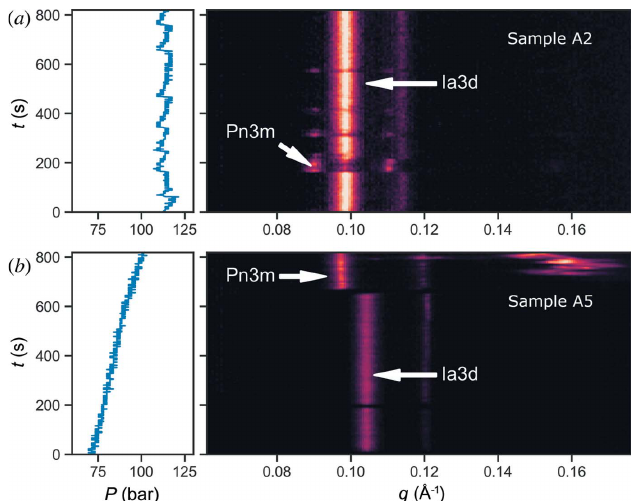
Figure 2 Illustrative data showing phase changes between the Ia 3 d and Pn 3 m cubic phases for samples injected in air at the Australian Synchrotron: ( a ) sample A3–MO, water 60:40 ( w / w ); ( b ) sample A5–MO/bR buffer and crystallization buffer 50:50. Reservoir pressure is shown in the left-hand plots, and radial scattering profiles are shown in the right-hand plots.